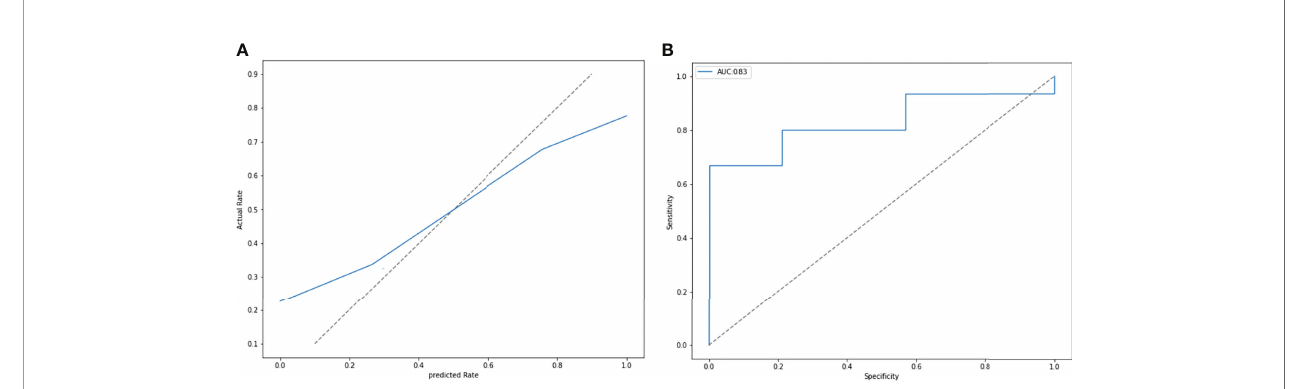
FIGURE 6 | (A) The calibration curve analysis and Hosmer-Lemeshow test for SVM model demonstrated the observations and predictions in validation cohorts were in good accordance. (P = 0.411). (B) External validation was performed by 30 patients from other hospitals. The SVM model had an AUC of 0.83.